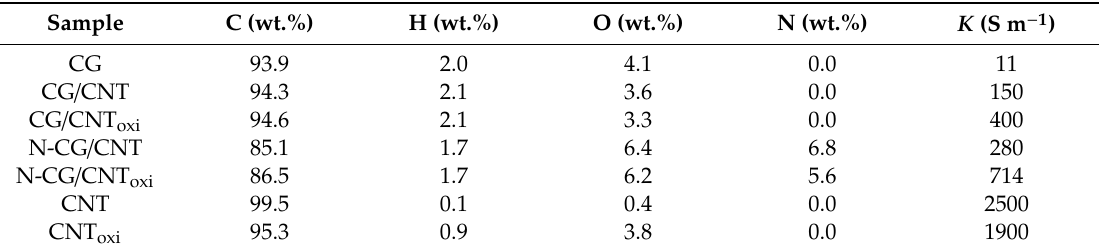
Table 2. Chemical composition and electrical conductivity of carbonized glucose, undoped and N-doped carbon composites, carbon nanotubes, and oxidized carbon